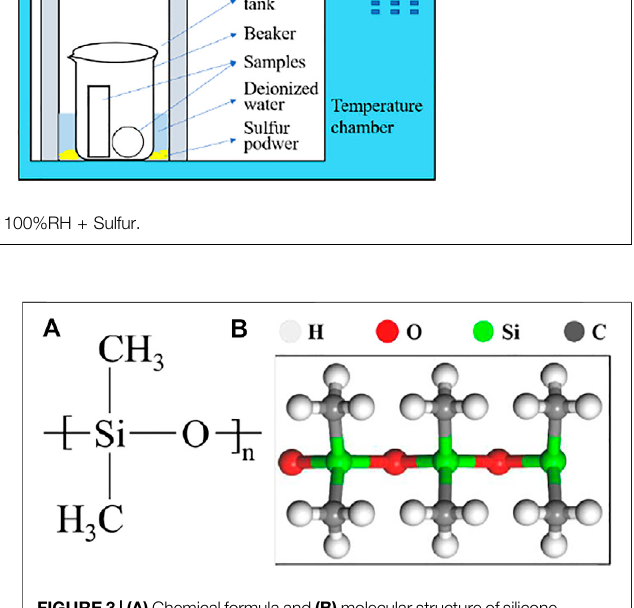
FIGURE3|(A) Chemicalformulaand (B)